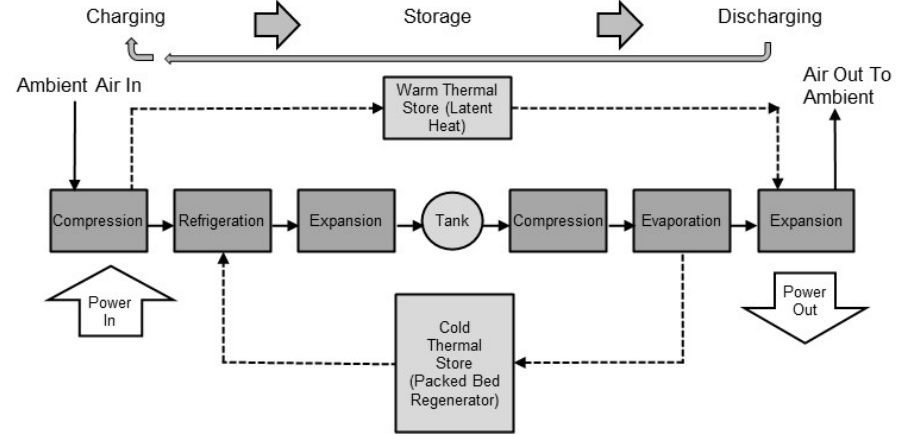
Figure 1. Simplified schematic of a liquid air energy storage device. Mass flows are shown with solid lines and thermal energy flows as dashed lines.